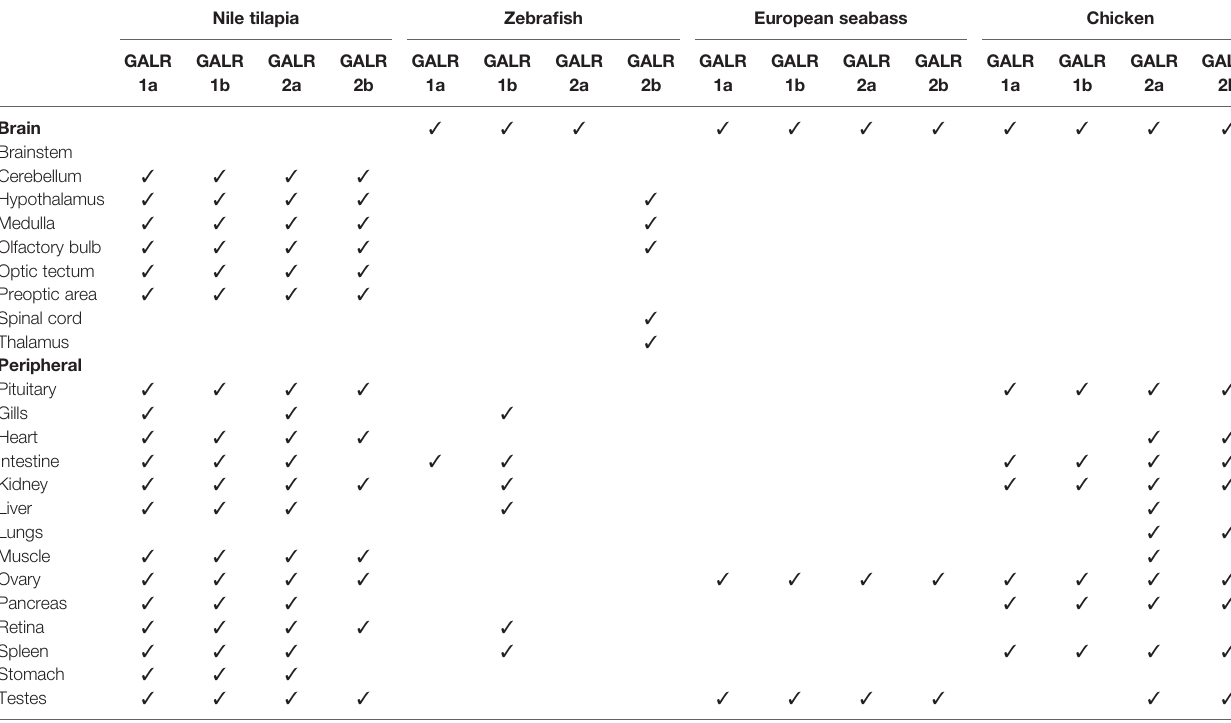
TABLE 2 | Localization of galanin receptor expression in non-mammalian vertebrates.